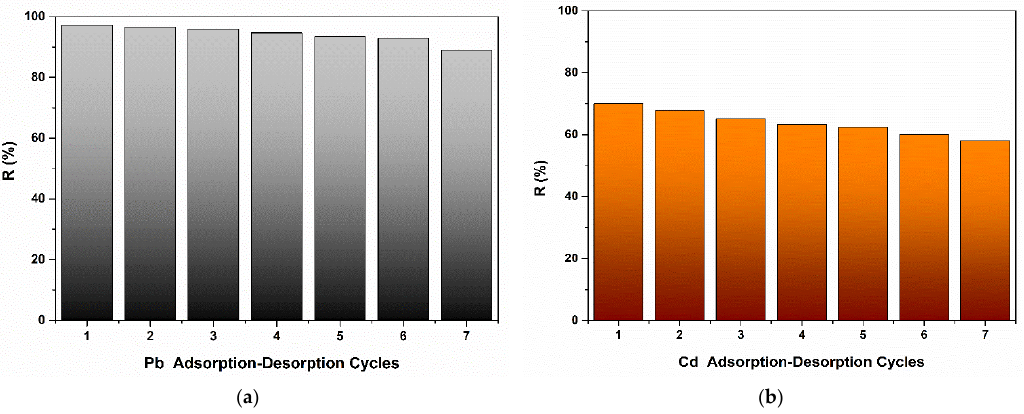
Figure 14. CHIT-PAAA recyclability study performed for ( a ) Pb and ( b ) Cd adsorption.